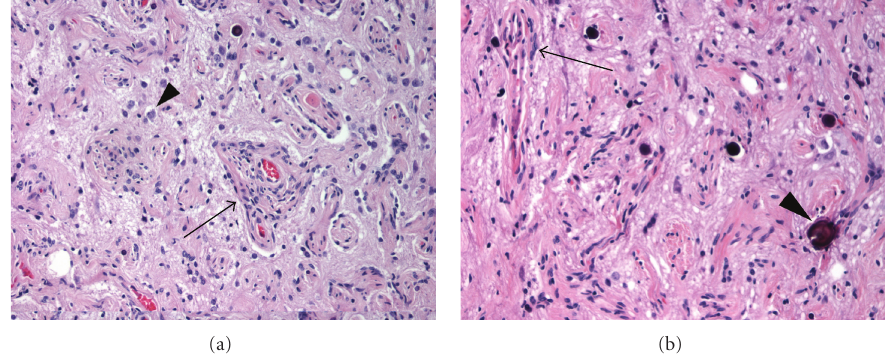
Figure 5: Histologic sections (200x) stained with hematoxylin and eosin (H&E) demonstrate greatly thickened vascular walls (a, arrow) within the cerebral cortex that are concentrically surrounded by meningioma cells, typical of meningioangiomatosis. Pyramidal cells (a, arrowhead) of the architecturally distorted cortex are noted between thickened vascular structures. In other regions (b, arrow), vessels showed fewer surrounding meningioma cells, but greater degrees of collagen, indicating substantial chronicity. Psammoma bodies (b, arrowhead) were scattered